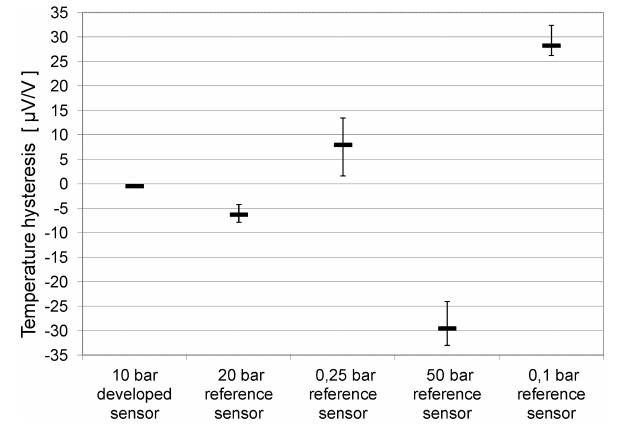
Figure 13. Temperature hysteresis of the zero point after 30/135 ◦ C with 24h at 135 ◦